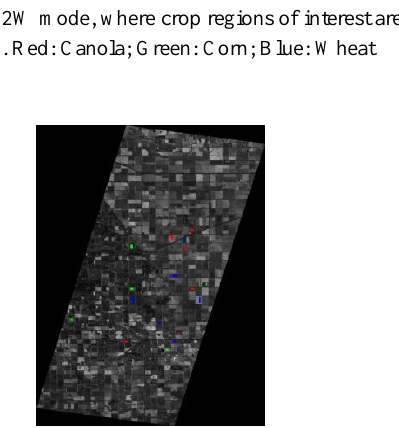
Figure 2. HH Image of TerraSAR-X acquired in May 30, 2012 in StipNear-005mode, where crop regions of interest are overlaid. Red: Canola; Green: Corn; Blue: Wheat The speckle reduction has also been performed to reduce noises inherited in the SAR image. A Polarimetric Gaussian-BoxCar Speckle filtering was used on a Coherency matrix T3 which performs incoherent averaging within a 5 by 5 sliding window. Figure 3 is an example of speckle reduced TerraSAR-X HH image subset. It can be seen that speckle reduced image is less random and the contrast is significantly enhanced.